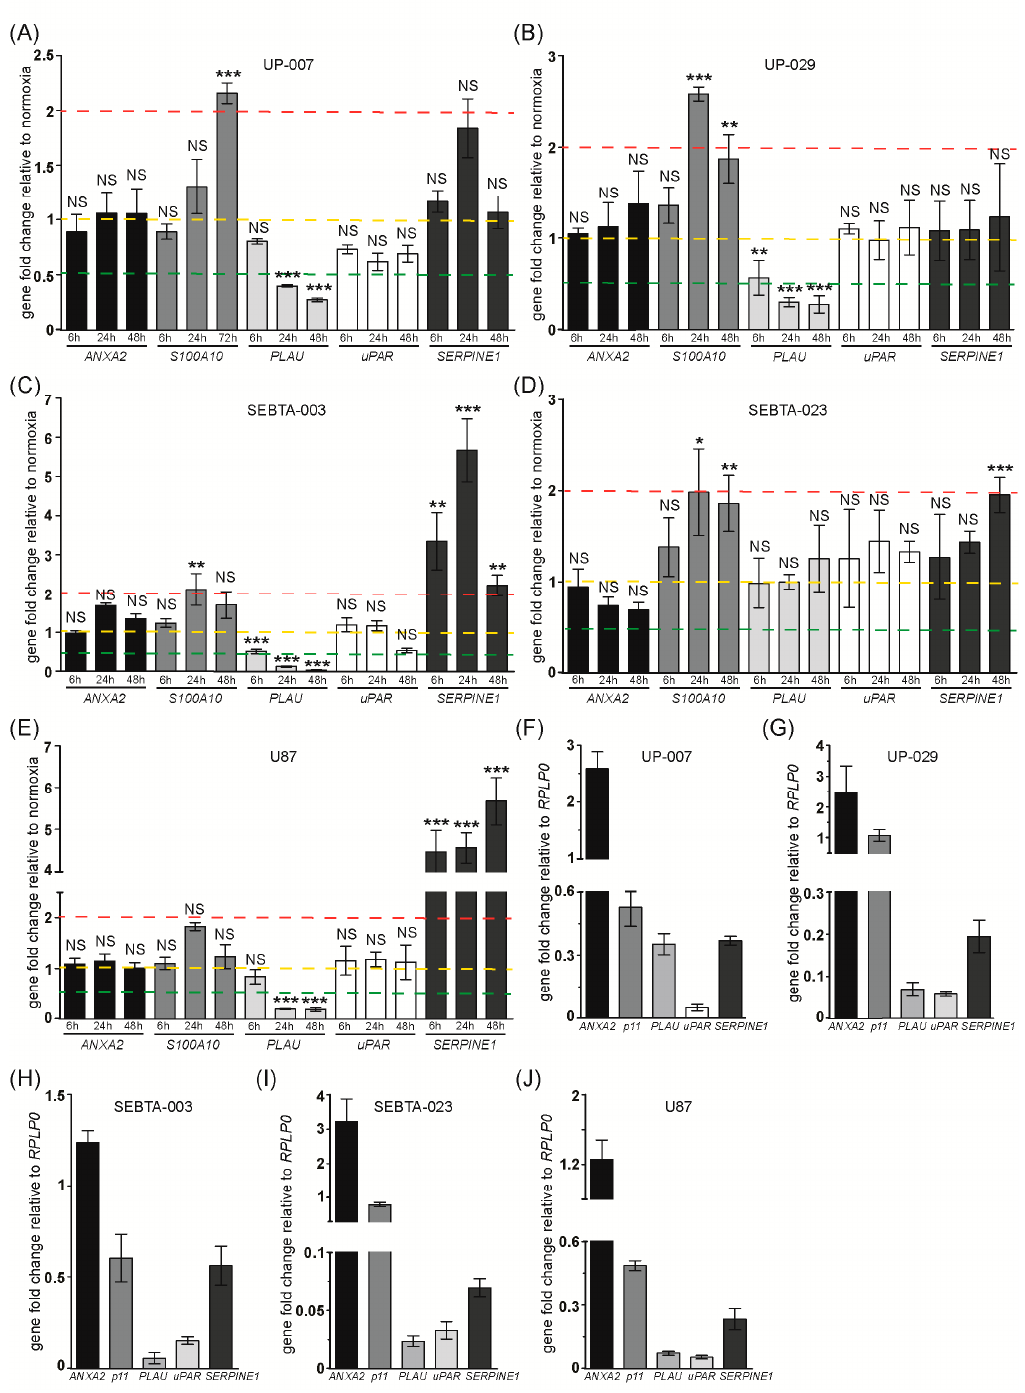
Figure 5. Analysis of invasion related genes in hypoxic GB cells. ( A ) UP ‐ 007; ( B ) UP ‐ 029; ( C ) SEBTA ‐ 003; ( D ) SEBTA ‐ 023; or ( E ) U87 cells were incubated under normoxia (21% O 2 ) or hypoxia (1% O 2 ) for the times indicated. RNA extraction was performed and gene expression was determined by RT ‐ qPCR. Gene expression levels were normalized to RPLP0 mRNA using the 2 −ΔΔ CT method [13]. Error bars represent the Standard Deviations obtained from the median value of at least three independent experiments, each performed in triplicate. Statistical analysis was evaluated using two ‐ tailed Student’s t ‐ test, comparing each hypoxia time ‐ point to the respective normoxic control. In every case a p value of less than 0.05 (*), less than 0.01 (**) and 0.001 (***) was considered statistically significant. Relative gene expression compared to the housekeeping gene, RPLP0, under normoxic